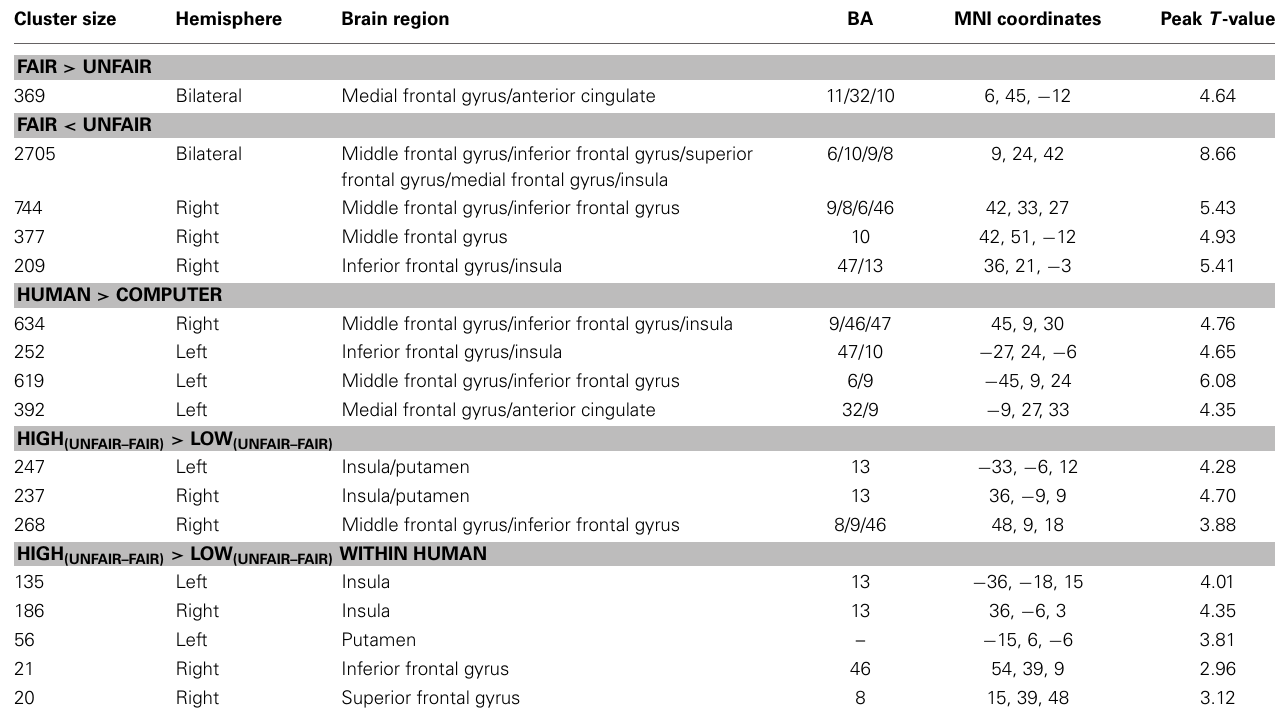
Table 2 | Results using a factorial model for analysis of the fMRI